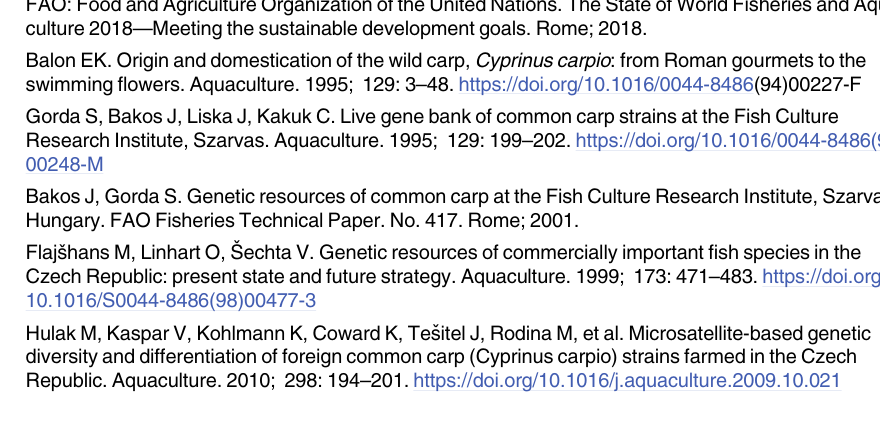
S5 Table. Results of the two factor ANOVA conducted to test the effects of different equili- bration (ES) and vitrification (VS) solutions on common carp spermatogonia post-thaw viability. Statistically significant factors are bolded. S6 Table. Results of the two factor ANOVA conducted to test the effects of exposures (1–2 min) to different VS on common carp spermatogonia post-thaw viability. Statistically sig- nificant factors are